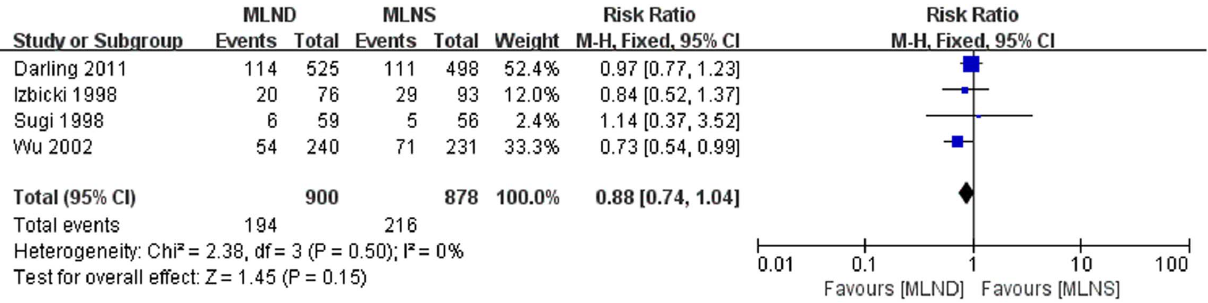
Figure 5. Forest plot of distant metastasis for the MLND vs. MLNS groups. MLND, mediastinal lymph node dissection; MLNS, mediastinal lymph node sampling; RR, risk ratio; CI, confidence